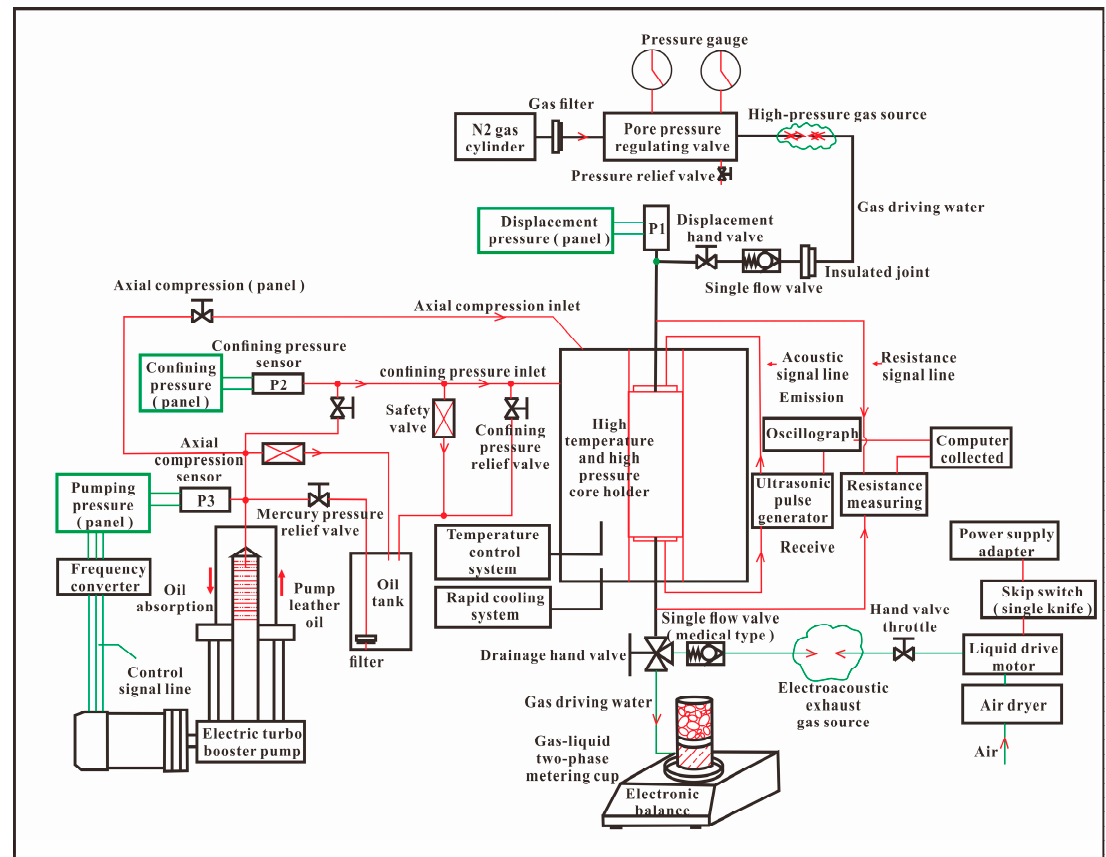
Figure 2. Working principle of the SCMS ‐ SD, a high ‐ temperature and high ‐ pressure rock sonic electrical measuring instrument.